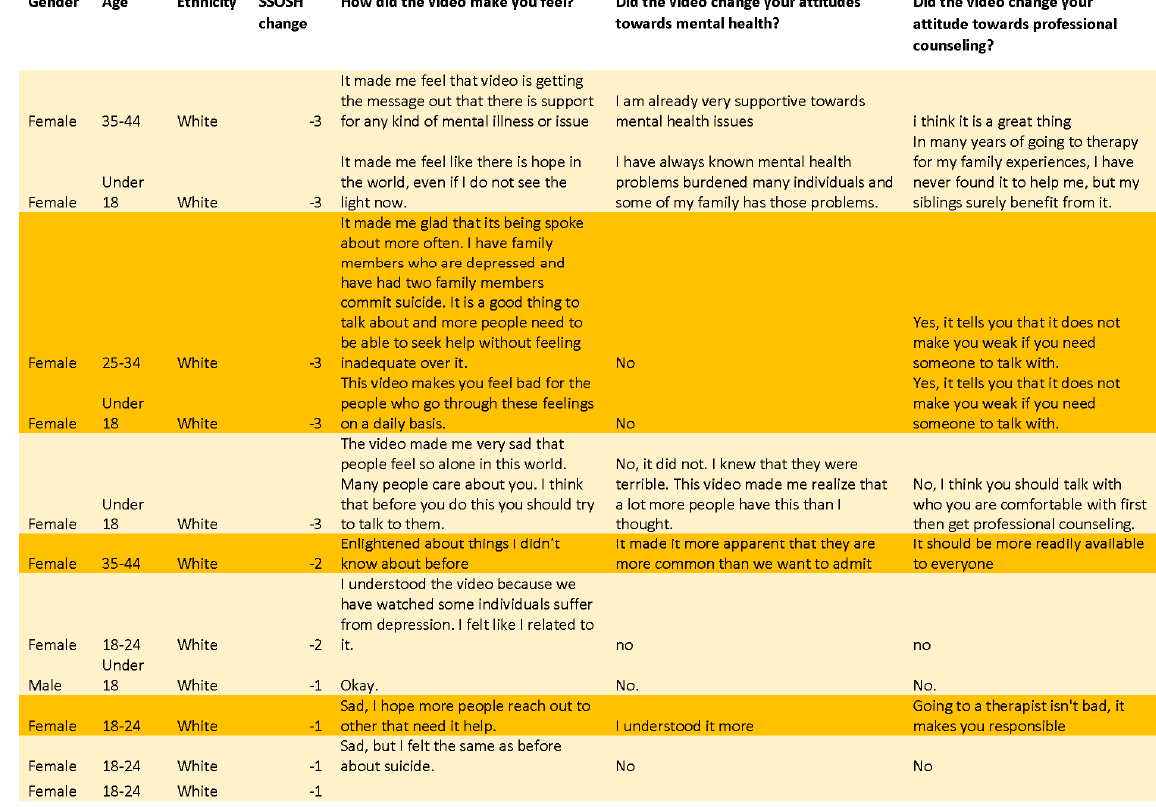
Figure 5. Group 2: small decreases in stigma score (0 to − 3). Participants were divided into two groups: those who expressed minor increased openness to counseling (dark orange) and those who expressed no change in attitudes towards counseling (light orange).